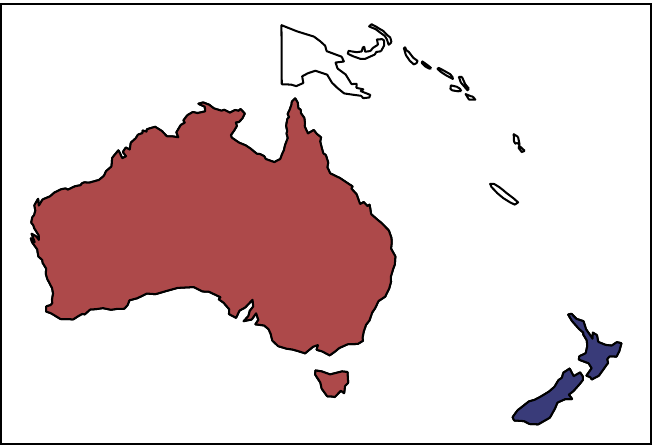
Figure 14. A map portraying the income groups of the most frequent collaborators of Oceanic nations. Nations colored in blue most frequently collaborate with high-income group nations, nations in green most frequently collaborate with upper-middle-income group nations, nations colored in red most frequently collaborate with lower-middle-income group nations, and nations colored in white did not have publications in the data